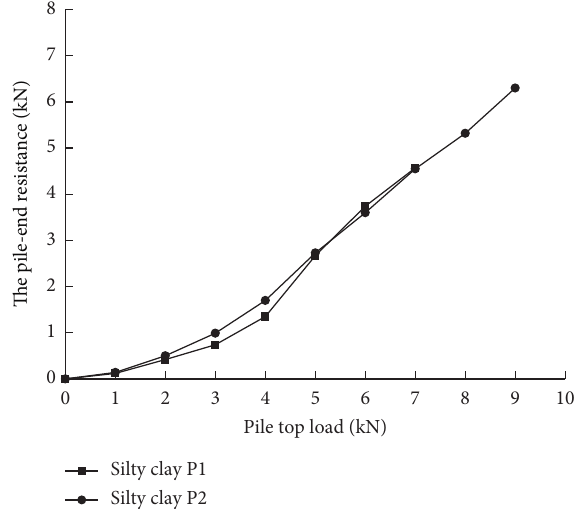
Figure 9: The tip resistance of piles with different diameters in various soil samples along with load change.